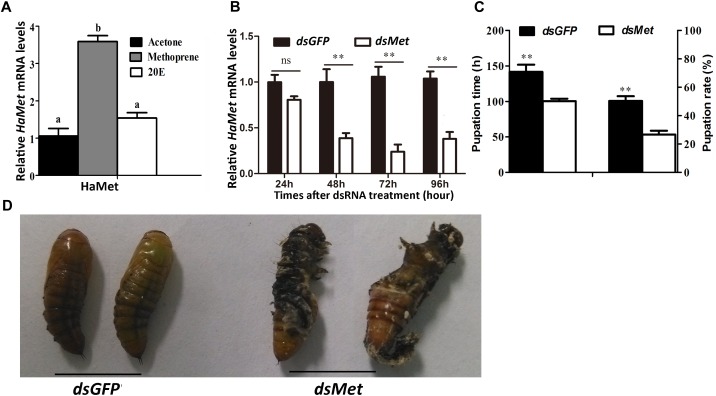
Knockdown of HaMet in 5th-instar H. armigera larvae. (A) The induction of HaMet expression by Methoprene (JH analog) or 20E. (B) The expression levels of HaMet in larval midgut after dsGFP or dsHaMet treatment examined at 24, 48, 72, and 96 h after treatment. (C) Statistical analysis of the pupation time and pupation rate after HaMet knockdown (30 larvae, three replicates). (D) The abnormal pupation after HaMet knockdown. Error bars indicate SE, ∗denotes P < 0.05, ∗∗denotes P < 0.01 (Student’s t-test). Different letters indicate significant difference between specimens (P < 0.05). ns, indicates no significant difference (P > 0.05).